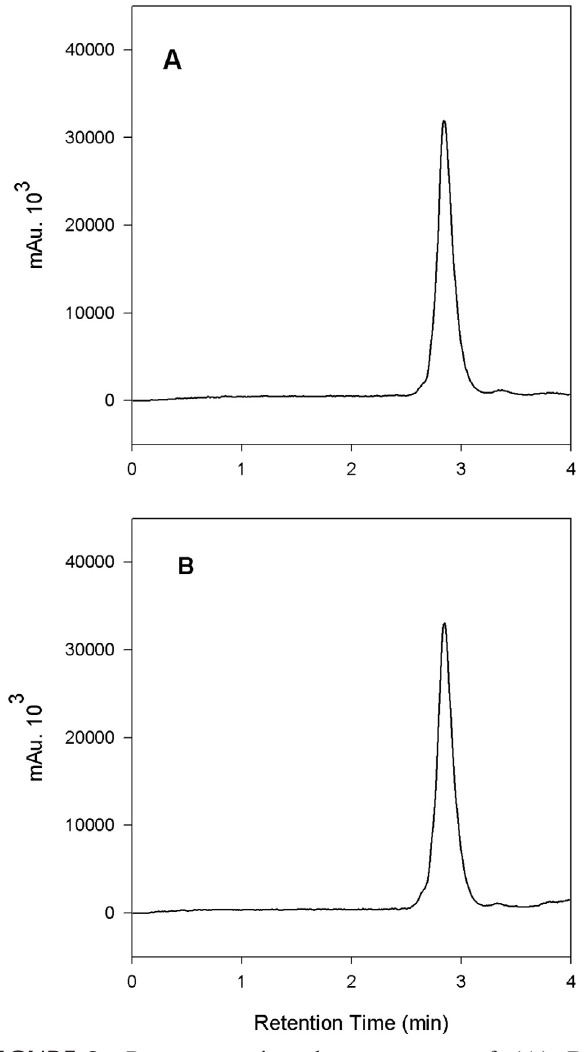
FIGURE 2 - Representative chromatogram of: (A): DG working standard (1000 µg/mL) and (B): formulation sample (1000 µg/mL). TABLE III - Calibration curves of the methods Parameters Linear